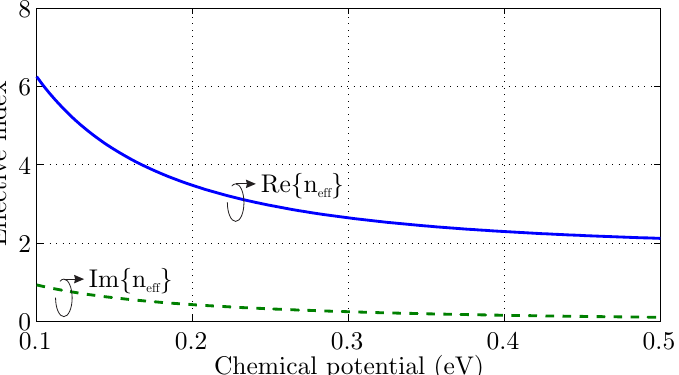
Figure 1. Effective index of an surface plasmon polariton (SPP) wave, for graphene atop silicon-oxide at 1THz and various chemical potential